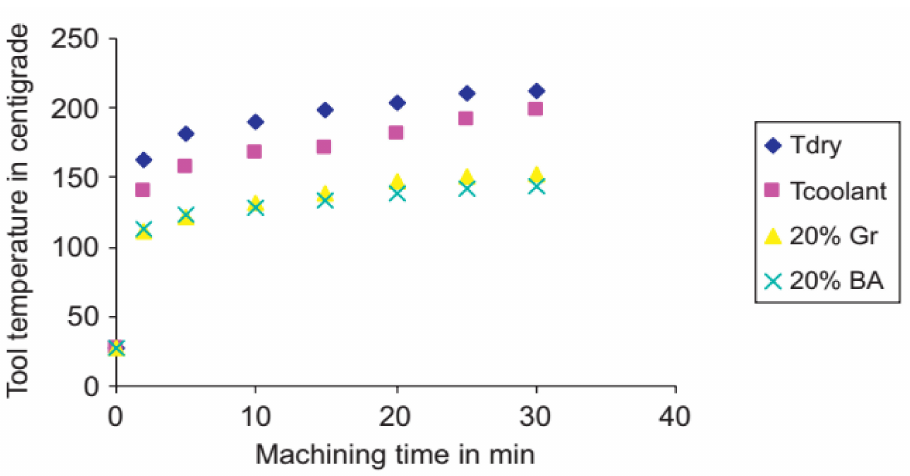
Figure 29. Tool temperature with time in different cutting techniques, reprinted with permission from ref. [151]. Copyright 2008 Elsevier